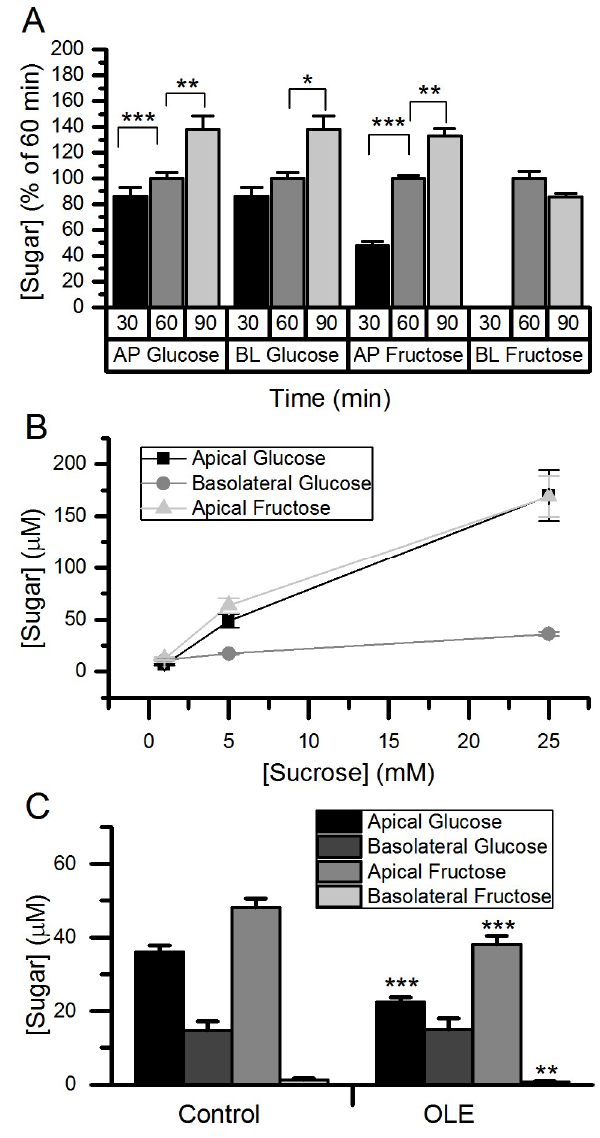
Figure 5. Hydrolysis and transport of sucrose in Caco-2 / TC7 cells. A time course for sucrose transport using 5 mM sucrose ( A ), and transport with 1, 5 and 25 mM sucrose for 60 min ( B ). Transport with 5 mM sucrose and 60 min after chronic OLE treatment at 1.5 mg / mL for final three days of di ff erentiation ( C ). Apical and basolateral glucose concentrations were determined by high performance anion exchange chromatography with pulsed amperometric detection (HPAE-PAD). Normalised results are presented as mean ± SEM, n = 18, * p < 0.05, ** p < 0.01, *** p < 0.001. AP = apical; BL = basolateral.